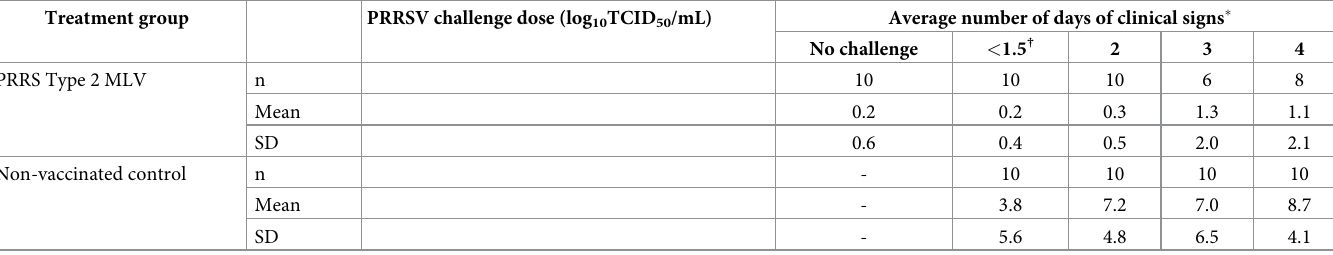
Table 4. Average number of days pigs showed any clinical signs, by treatment group and challenge dose. Treatment group